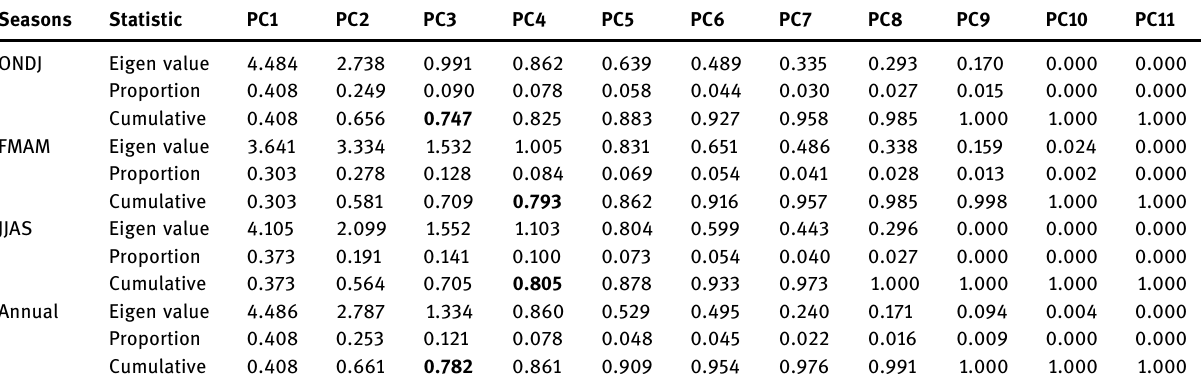
Table 2: Eigen value for ONDJ, FMAM, JJAS, and annual rainfall in the study area Seasons